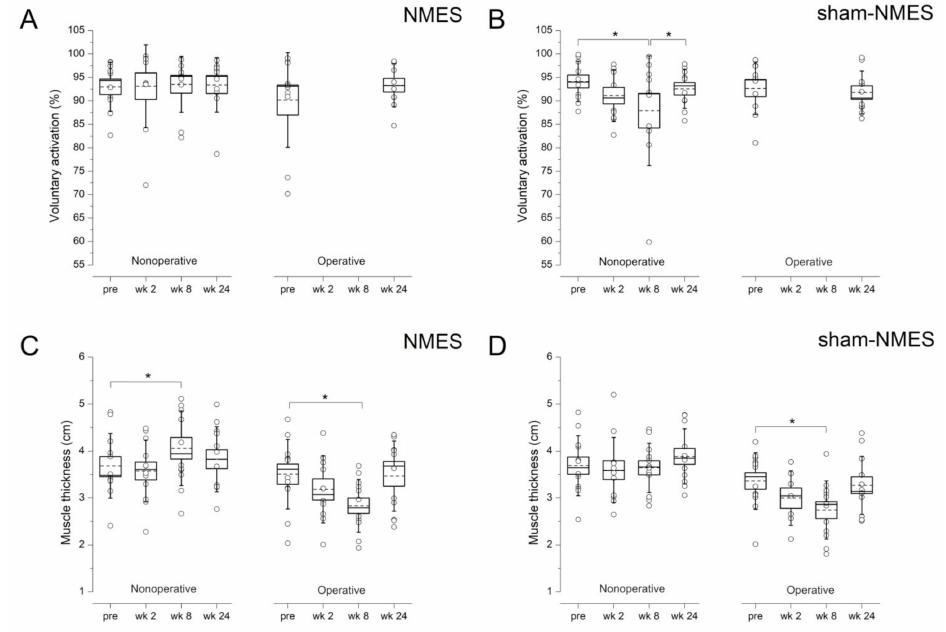
Figure 4. Quadriceps voluntary activation ( A , B ) and muscle thickness ( C , D ) of the operative and nonoperative side at the different time points in the NMES and sham-NMES groups. The box represents the standard error, the horizontal lines within the box represent the median and the mean, and the whiskers represent the standard deviation (single data are also shown). * p < 0.01. In both groups, KOOS pain, symptoms and activities of daily living scores decreased from pre to week 2 ( p < 0.01), increased from week 2 to week 8 ( p < 0.001)—while being still lower than pre values ( p < 0.05)—and finally increased again from week 8 to week 24 ( p < 0.05), with no difference between week 24 and pre (Table 3). KOOS quality of life score decreased from pre to week 2 ( p < 0.001), increased from week 2 to week 8 ( p < 0.001), and also from week 8 to week 24 ( p < 0.001), reaching a level higher than pre ( p < 0.001). Table 3. Self-reported knee function (KOOS) data by group and time point. Group Pre Week 2 Week